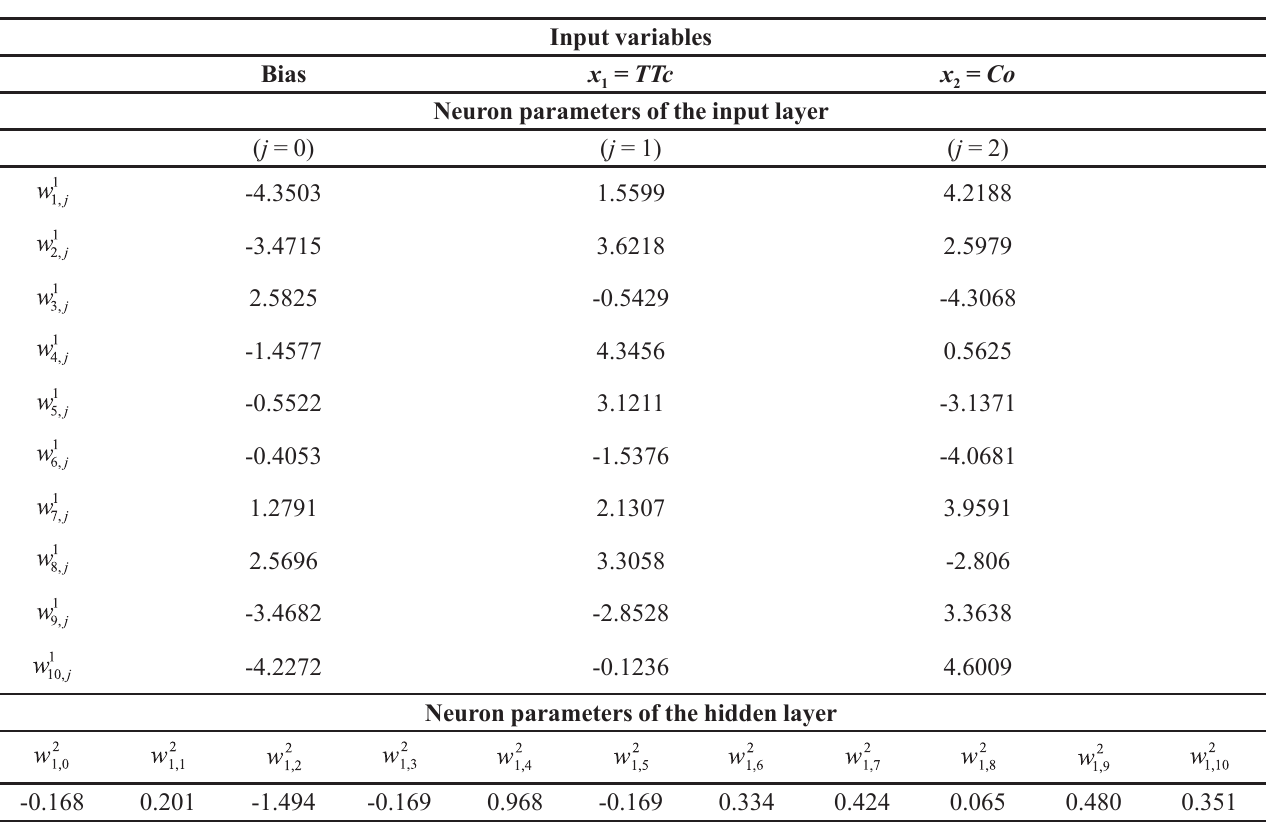
TABLE X - Parameters found for ANN associated to data in Table VI and Equation 6